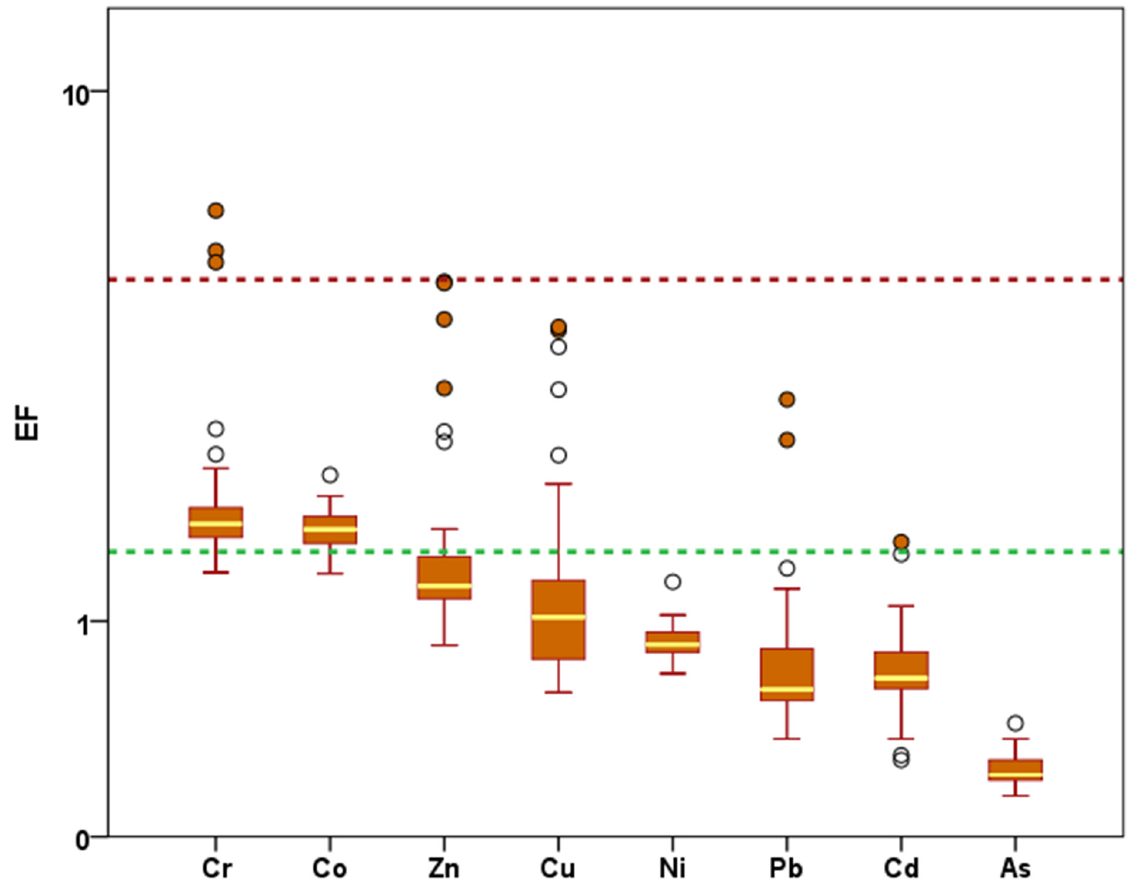
Figure 3. Enrichment factor of trace metals in sediments from the Sebou basin normalized to the Tafna bedrock [29]. The upper outliers (above 1.5) are for stations S3, S4, and A1. Mostly the orange circles indicate the Fez station (S3). The dashed green and red lines indicate the EF values of 1.5 and 5, respectively.